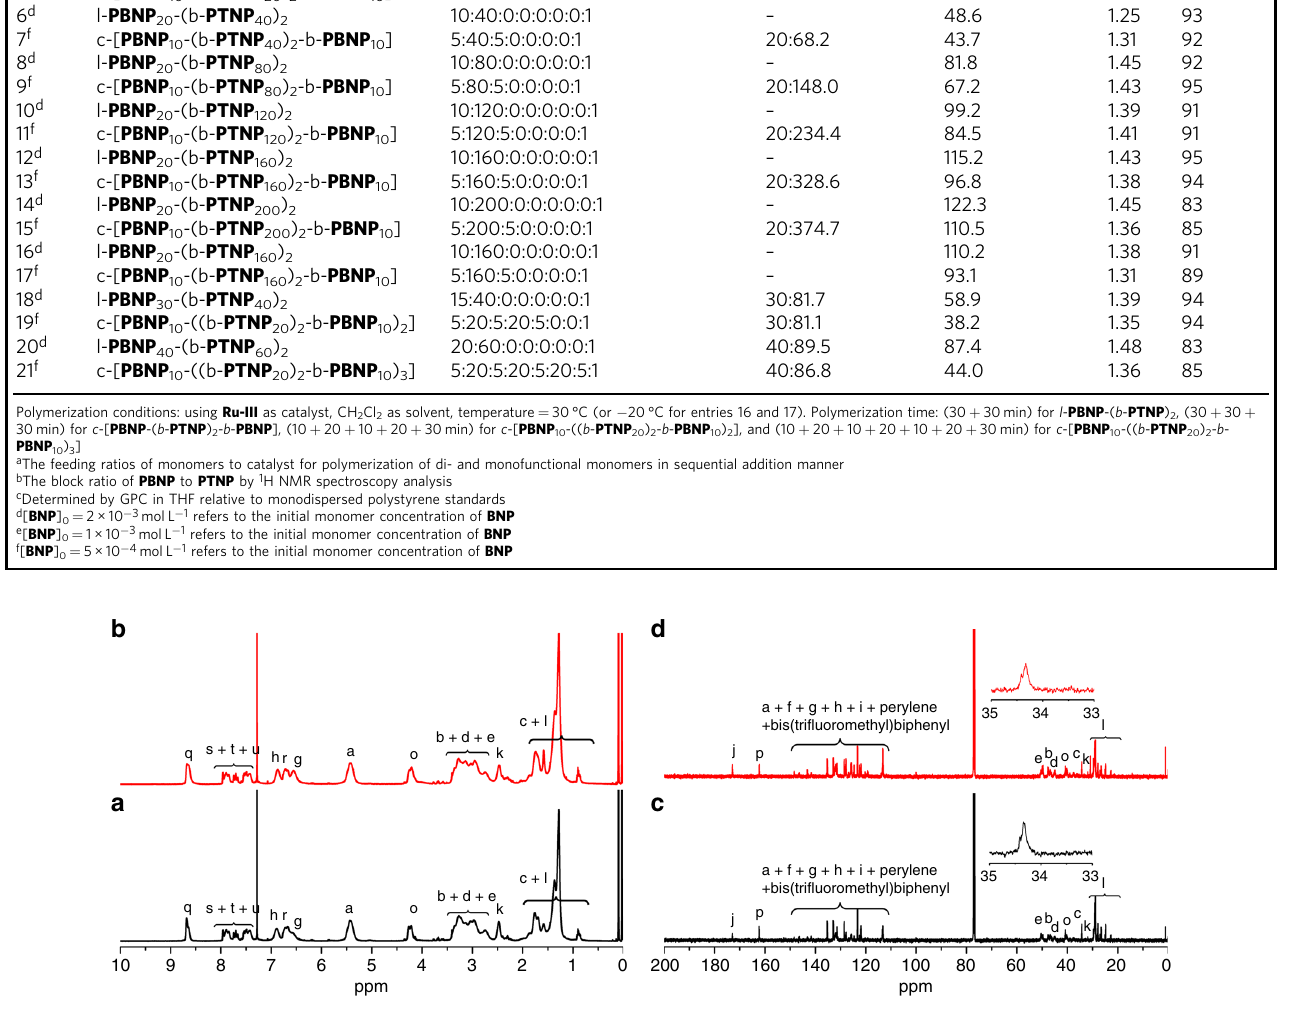
Fig. 3 The NMR spectra of linear and monocyclic polymers. 1 H ( a , b ) and 13 C ( c , d ) NMR spectra of l - PBNP 20 -( b - PTNP 20 ) 2 ( a , c ) and c -[ PBNP 10 -( b - PTNP 20 ) 2 - b - PBNP 10 ] ( b , d ) in CDCl 3